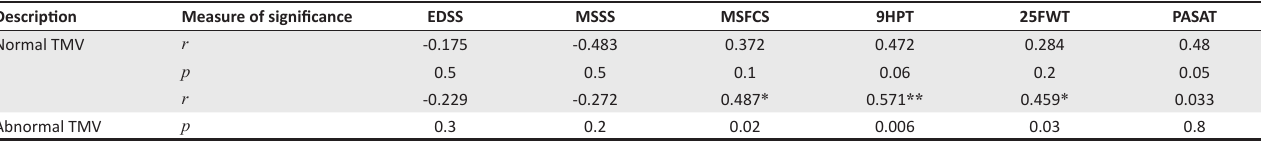
TABLE 5: Total macular volume correlation with measures of disability in patients with multiple sclerosis. Description Measure of